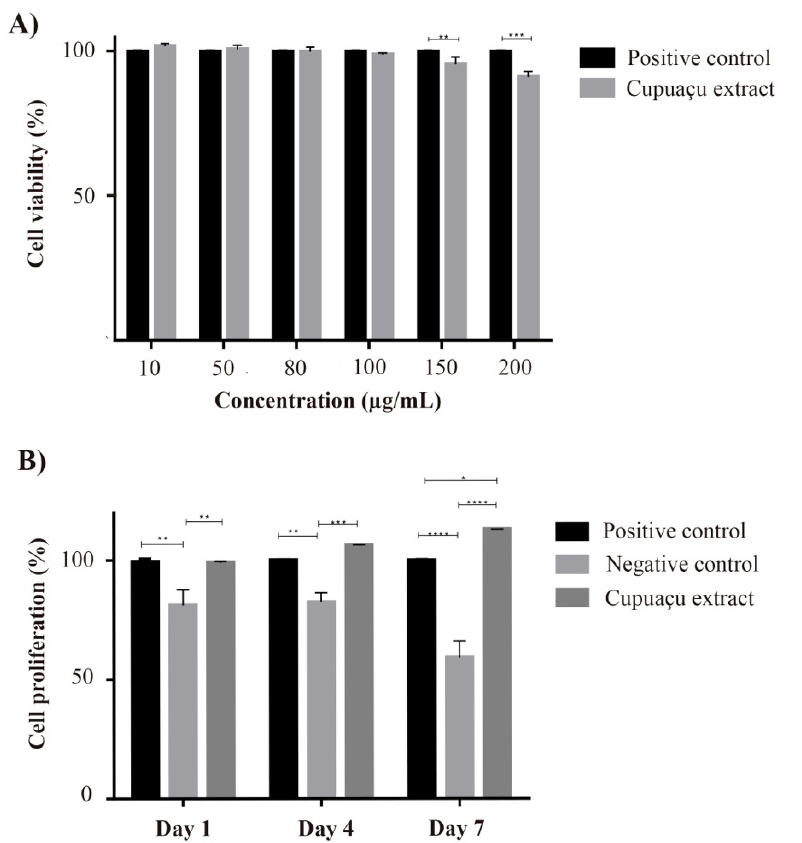
Figure 1. Primary human dermal fibroblast response to Cupuaçu extract treatment. ( A ) Cellular viability after 24 h incubation with different concentrations of Cupuaçu extract; ( B ) cellular proliferation for up to 7 days incubation with 100 μ g/mL Cupuaçu extract. The graphs represent the absorbance mean value and standard deviation of three biological replicates in triplicates, normalized according to the 100% viability/proliferation positive controls. Positive controls received FBS supplementation and negative controls consisted of cells maintained without FBS supplementation. Statistical differences have been verified by two-way ANOVA test and Tukey post hoc test. * p < 0,05; ** p < 0.01; *** p < 0.001; **** p < 0,0001.